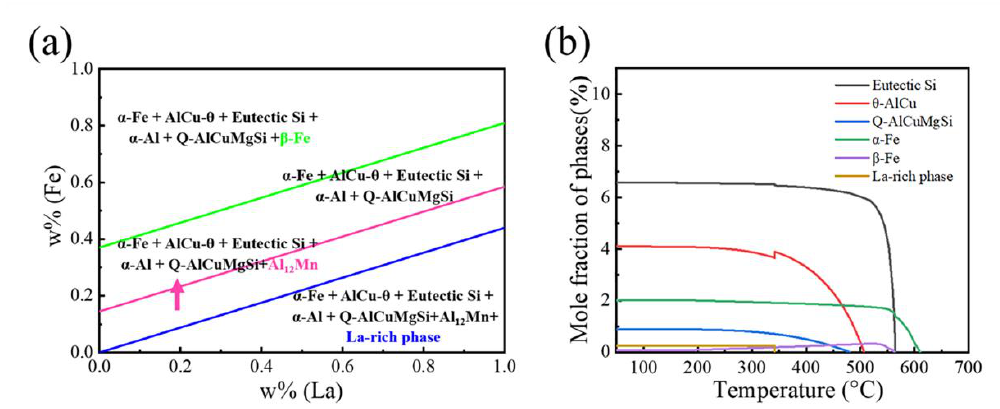
Figure 1. ( a ) Effect of Fe/La content on intermetallic compounds in W319 alloy at room temperature; ( b ) Phase fraction as a function of temperature at equilibrium for the W319 + 0.1La alloy system. In addition, we calculated the equilibrium phase diagram of Al-7.3Si-3.5Cu-0.3Mg- 0.4Fe-0.3Mn-0.03Ti-0.1La at room temperature that was used to guide the subsequent ex-